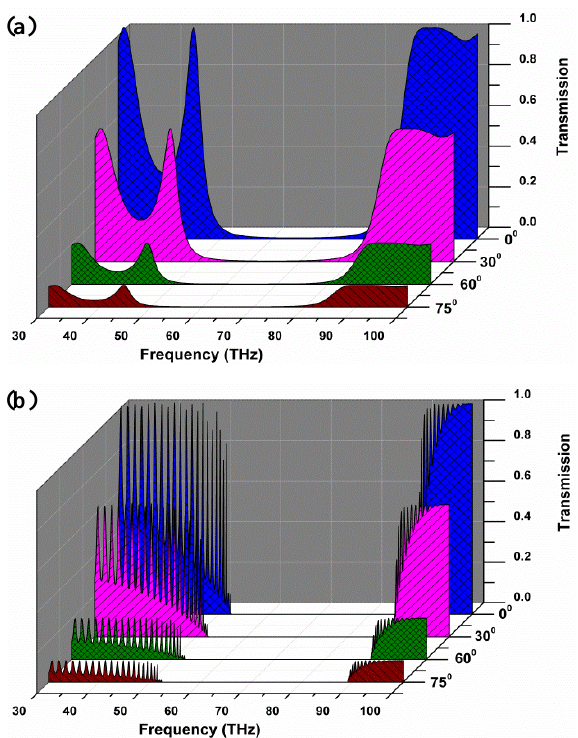
Figure 7: TE Transmittance spectrum of SbSBr based Conventional Photonic crystal structures of (a) 5th and (b) 10th generations from 0° to 75°.